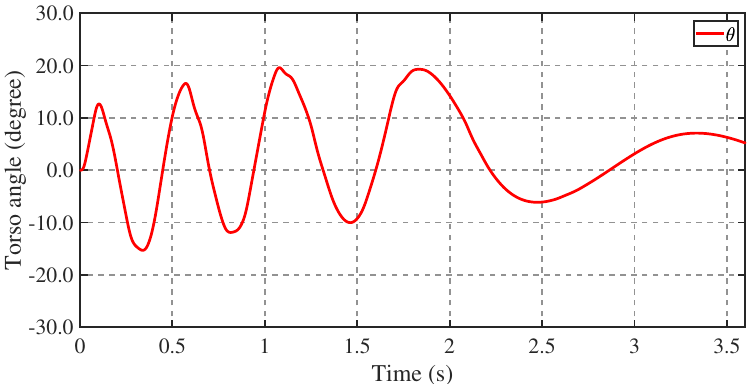
Figure 14. Trajectory of the torso angle when the robot slides on terrain with a variable friction coefficient.